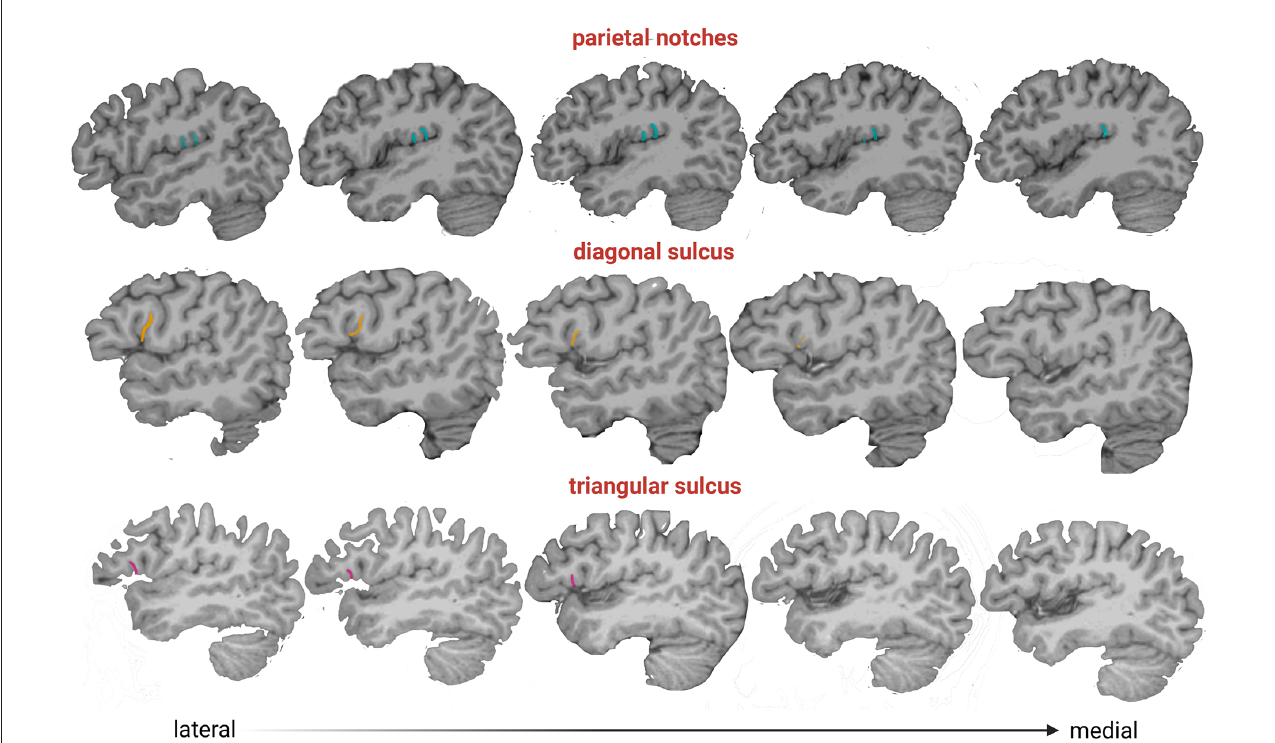
FIGURE3 Parasagittal slices from lateral to medial (left to right), where accessory sulci can be observed and their depth. Color legend: pink, triangular sulcus; orange, diagonal sulcus; light blue, parietal notches.